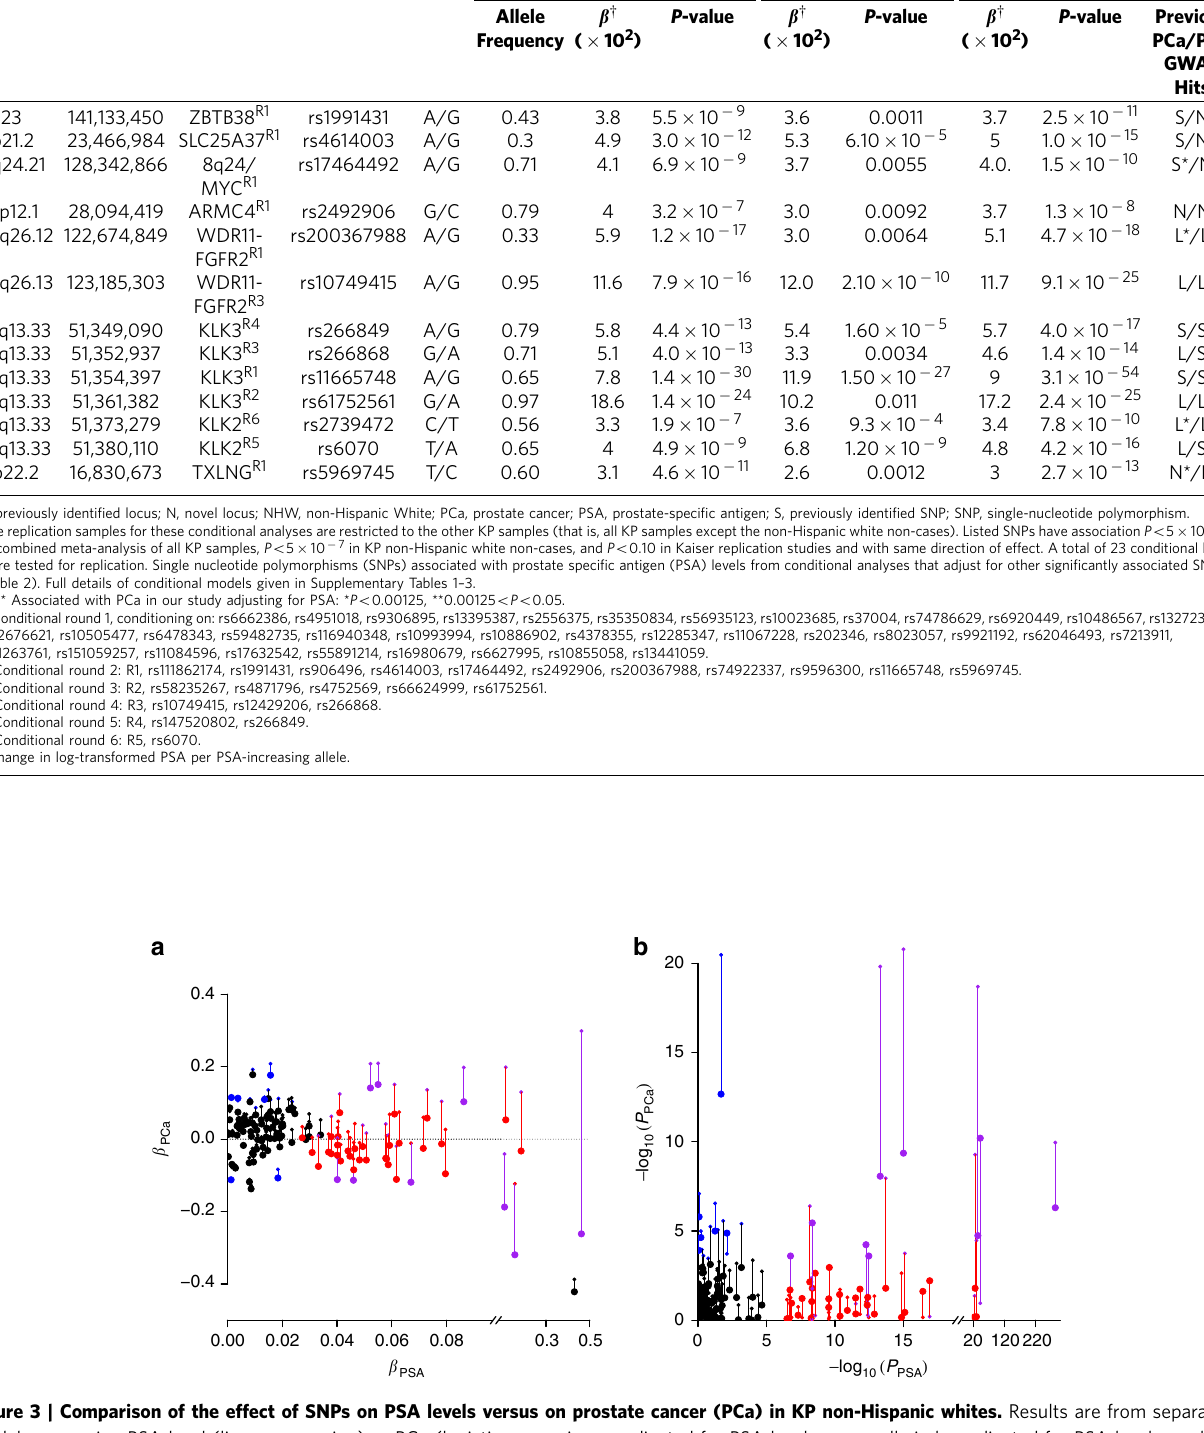
Table 3 | Conditional genome-wide association study results. Chrom Position